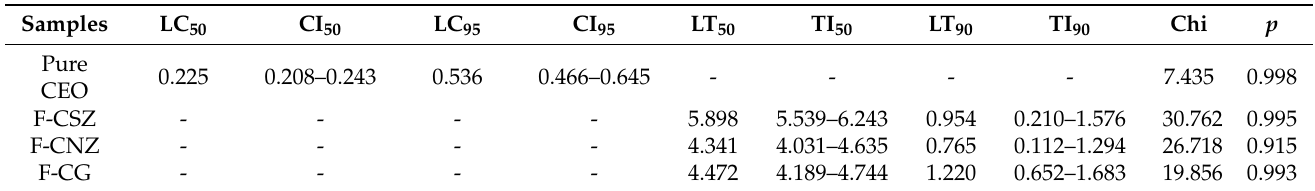
Table 4. The lethal concentrations ( µ L L − 1 ) of pure CEO and the lethal time (day) of encapsulated CEO EC formulations with an appropriate confidence intervals, chi, and p